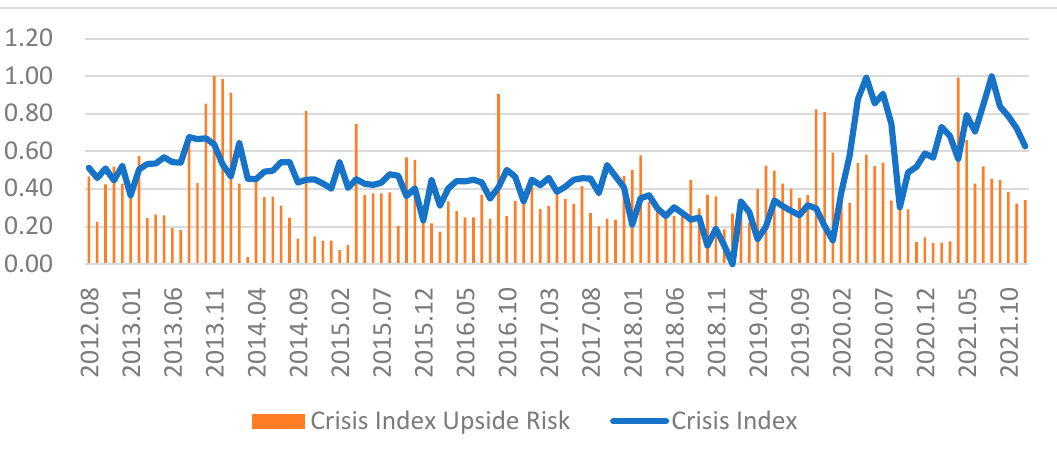
Figure 6. Comparison of Crisis Index and Crisis Upside Risk Trends in the Energy Industry.